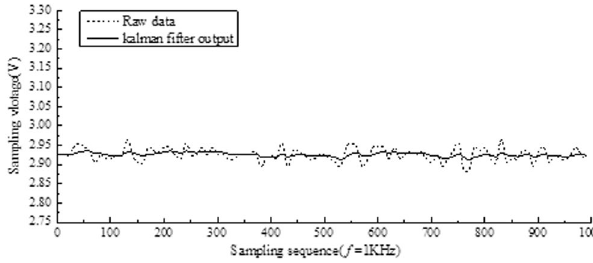
Figure 4. Filtering results and the original data comparison